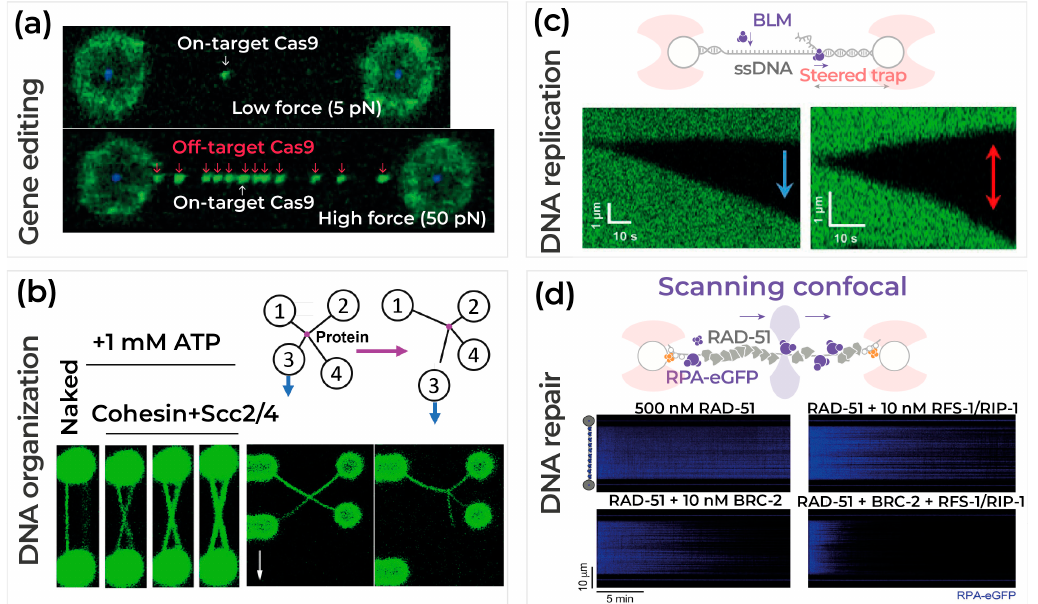
Figure 2. Understanding various DNA–protein interactions using correlated optical tweezers fluorescence microscopy. ( a ) Gene editing: a DNA molecule tethered between two optically trapped beads. The upper panel shows the on-target activity of the Cas9 protein when the DNA is held at a low force of 5 pN. Conversely, at a high force (50 pN), when the DNA molecule is stretched and under strain, several off-target activities appear, as shown with red arrows. ( b ) DNA organization: the left side depicts a cohesin bridge between two DNA molecules formed during the incubation of two DNA tethers in cohesin, ATP, and SCC2/4. The figure on the right shows how using 4 optically trapped beads can help in studying cohesin bridges between DNA molecules. Two DNA molecules were tethered between beads #1–2 and #3–4, respectively. Bead #3 was moved downward in the z-axis to apply force to the bridge (the blue and white arrows show this vertical movement) and measure its strength and sliding property. As shown, the cohesin tether keeps sliding on the DNA even after the exerted force breaks the high-affinity bond between the biotinylated DNA end and the streptavidin-coated bead. ( c ) DNA replication: Schematic of DNA unwinding mechanism by BLM helicase. The kymographs were formed when the fluorescence laser scanned the tethered DNA molecule continuously over 10 s. Sytox orange stain (green) was used to examine the dsDNA transition to ssDNA, where the absence of green fluorophore is an indicator of ssDNA. The left kymograph was acquired in the presence of 200 nM BLM at 30 pN, which showed unidirectional BLM’s DNA unwinding behavior. The right kymograph was obtained in the presence of 50 nM hRPA and BLM under the same amount of force (30 pN). ( d ) DNA repair: an experimental schematic where an optical tweezers-based single-molecule technique was used to resolve individual RAD-51 filament growth and measure their growth rates in replacing RPA-covered resected DNA in the HR repair mechanism. The impact of RFS-1/RIP-1 and BRC-2 on the RAD51 growth was shown in the kymographs. As depicted, RFS-1/RIP-1 has a stronger impact on the growth rate of individual RAD-51 nuclei in comparison with BRC-2. Figures are adapted with permission from reference [97], Copyright (2019) Springer Nature and open source references